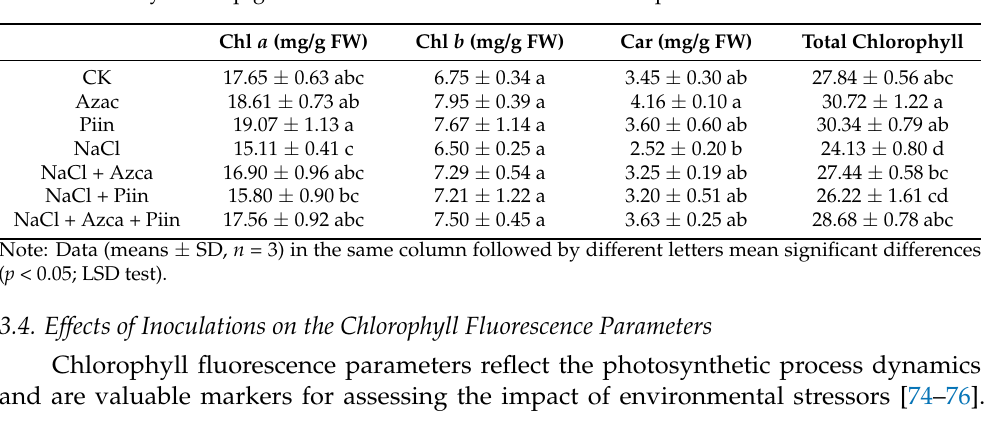
Figure 4. Shoot fresh weight of tomato plants under different treatments at the harvest. Shoots in- cluded stems, leaves, and fruits. Results were shown as mean ± SE ( n = 10). The means with the same lowercases indicate that the differences were insignificant ( p > 0.05). Table 1. Photosynthetic pigment concentrations in leaves of tomato plants under different